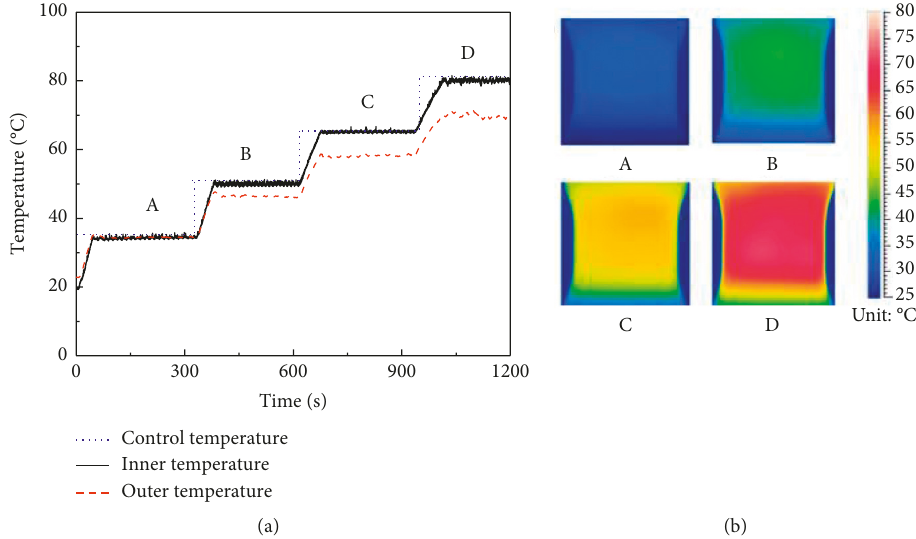
Figure 3: Verification of temperature control. (a) Temperature difference between inner surface and outer surface of the specimen at different temperatures. (b) Thermal image of temperature distribution on the outer surface of the specimen at different temperatures.